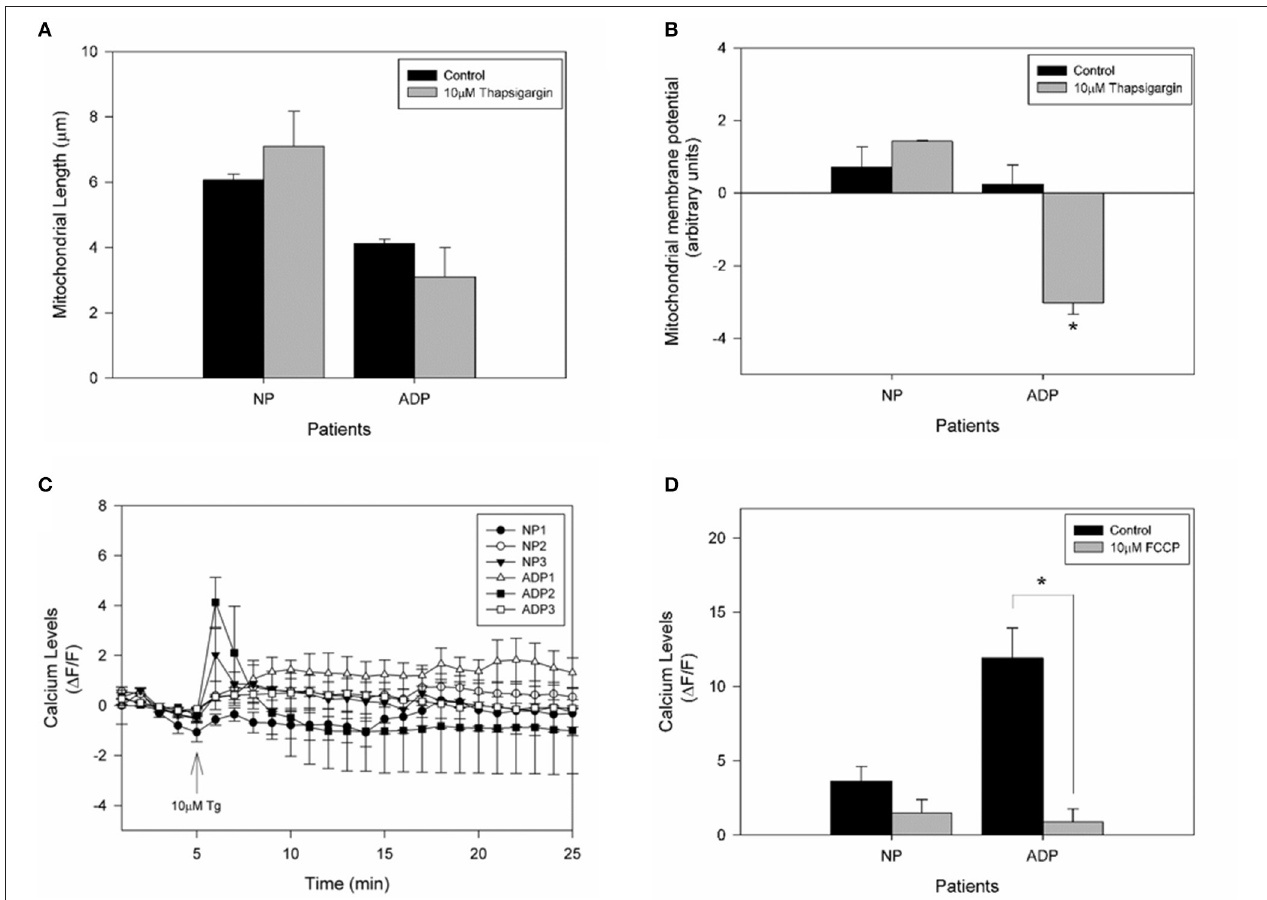
FIGURE 5 | Calcium overload induces mitochondrial impairment in AD fibroblasts. (A) Determination of mitochondrial length changes after 1min treatment with thapsigargin. Data are mean ± SE, n = 3 (technical replicates for each subject). (B) Mitochondrial membrane potential levels determinate with TMRM of each patient after 10 µ M thapsigargin treatment. Data are mean ± SE, n = 3 (technical replicates for each subject). * p < 0.05 indicate differences before and after thapsigargin treatment calculated by Student t -test. (C) Fibroblasts were treated with 10 µ M FCCP for 30min before the experiment was performed. Quantification of the intensity of Fluo3 showing cytosolic calcium levels over 25min. After 5min of basal fluorescence detection, the cells were treated with 10 µ M of thapsigargin (arrow). Data are mean ± SE, n = 3 (technical replicates for each subject). (D) Quantification of cytosolic calcium levels after 1min treatment with thapsigargin. Data are mean ± SE. * p < 0.05 indicated differences with or without FCCP, calculated by Student t